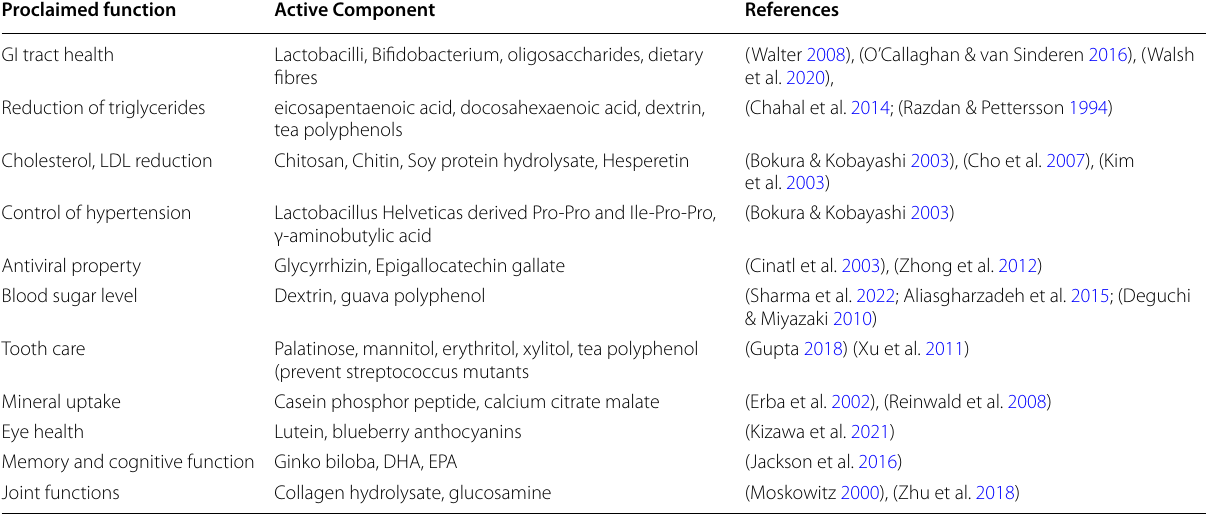
Table 1 Various functional ingredients used as functional food components for proclaimed health benefits Proclaimed